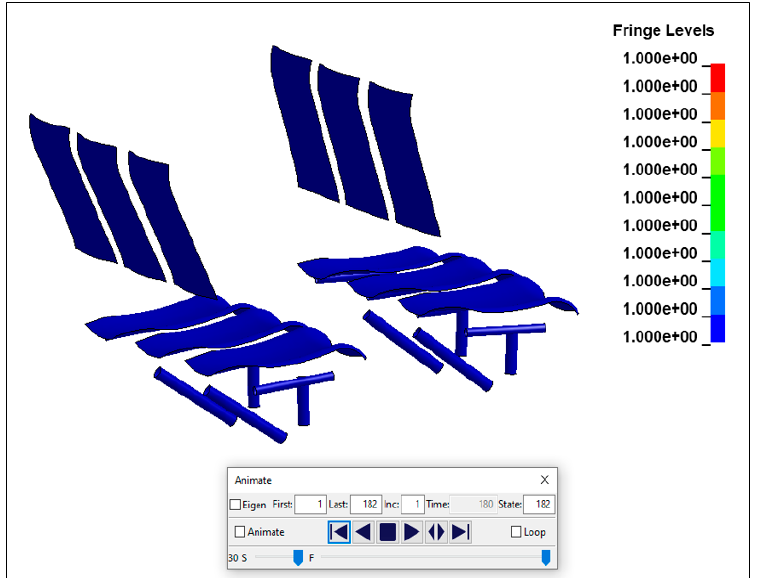
Figure 14. Failure study of the primary loading path’s composite components for test 3.